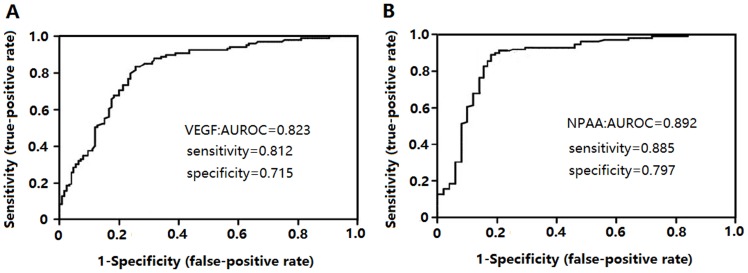
Receiver-operating curve (ROC) analysis of platelet derived VEGF and NPAA in the detection of lung cancer.(A,B) ROC analysis of lung cancer patients and healthy controls, and healthy controls as a negative group and patients with lung cancer as a positive group. NPAA had the best predictive diagnostic accuracy (AUC = 0.893, P<0.0001). AUROC: area under receiver-operating curve.